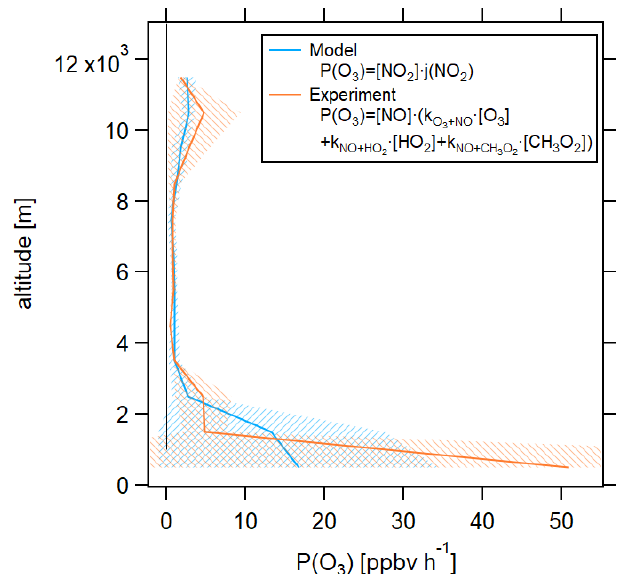
Figure 6. Modeled and experimental vertical profiles of P (O 3 ) for HOOVER. Modeled P (O 3 ) was calculated via NO 2 photolysis, and experimental P (O 3 ) was calculated via the extended Leighton ratio as shown in Eq.